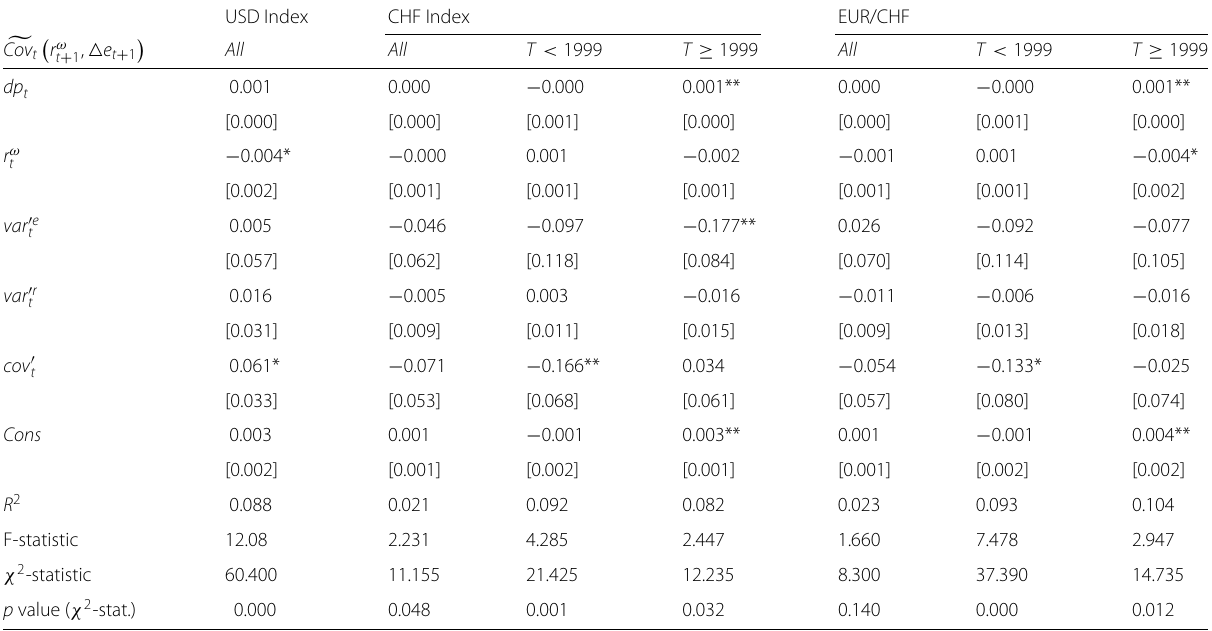
Table 5 First-stage